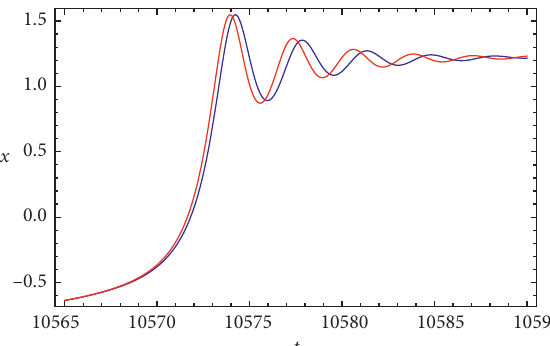
Figure 15: Time history of system (36). The red line represents the curve before time-delay approximation, and the blue line repre- sents the curve after time-delay approximation when the param-